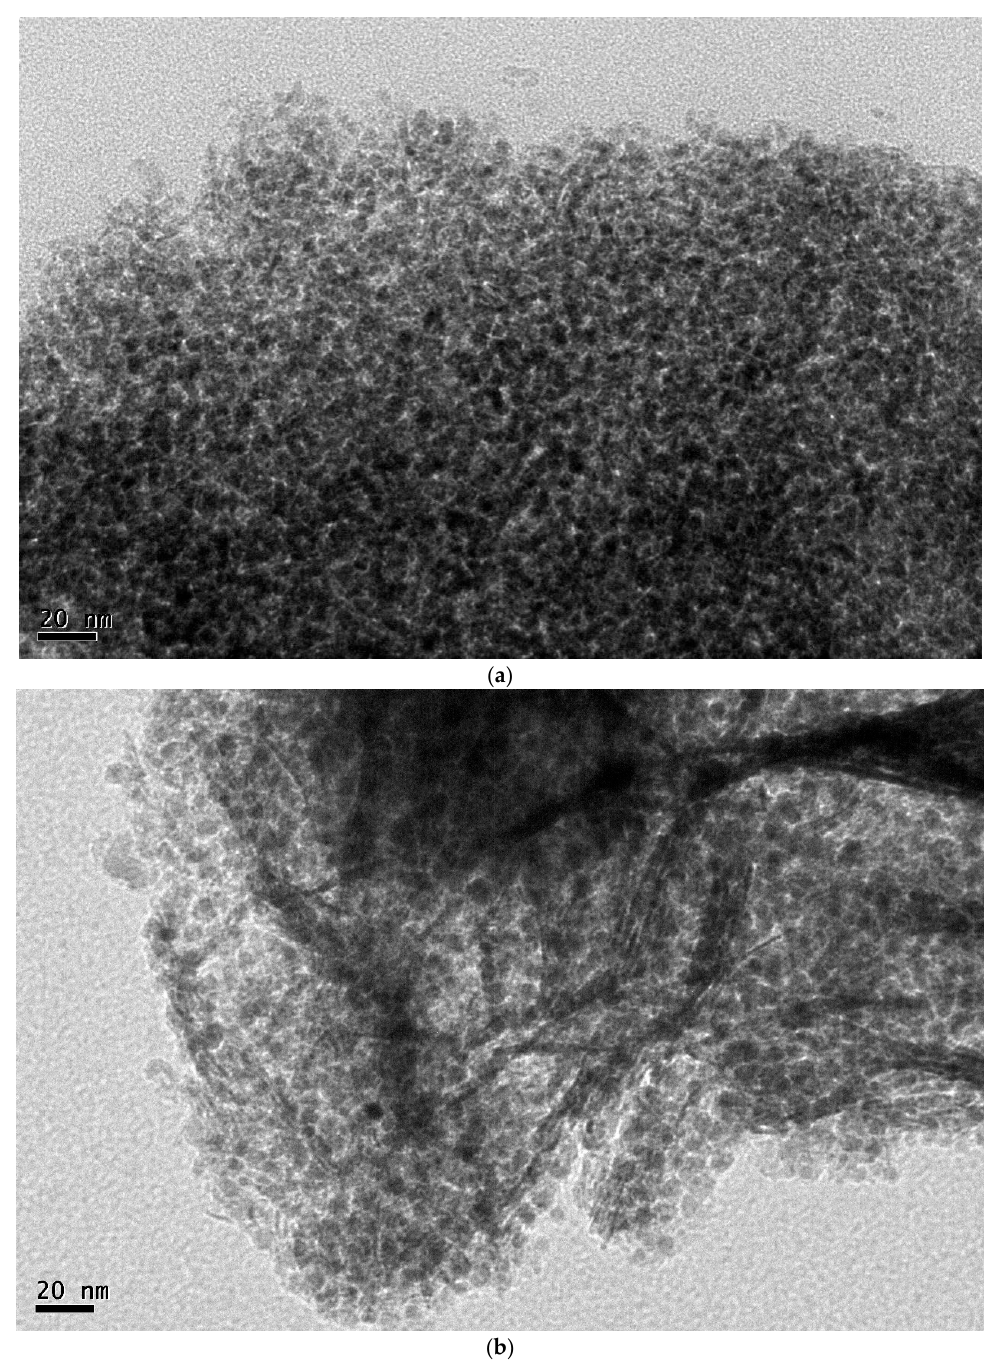
Figure 2. Transmission electron microscope (TEM) images of the Ni/Al 2 O 3 ( a ) and Ni 2 P/Al 2 O 3 ( b ) catalyst.